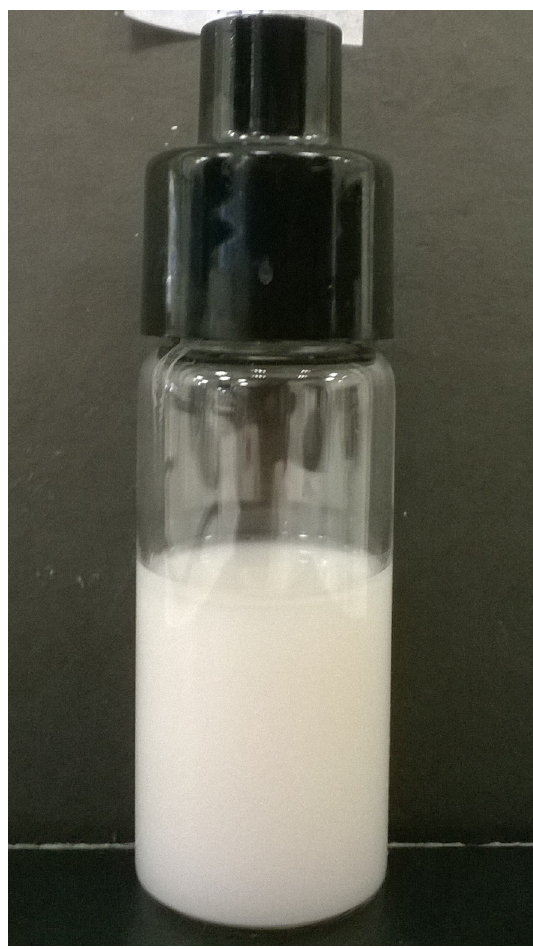
Figure 2. Maltodextrin nanoparticle dispersion in silicone. Table 2. Characterization Results of Maltodextrin PCN.